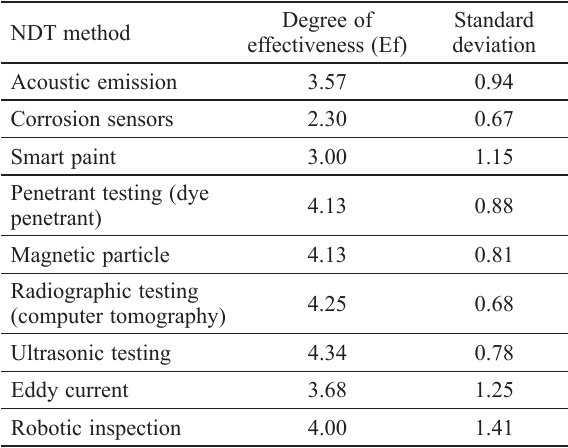
Table 12. Steel NDT methods: degree of